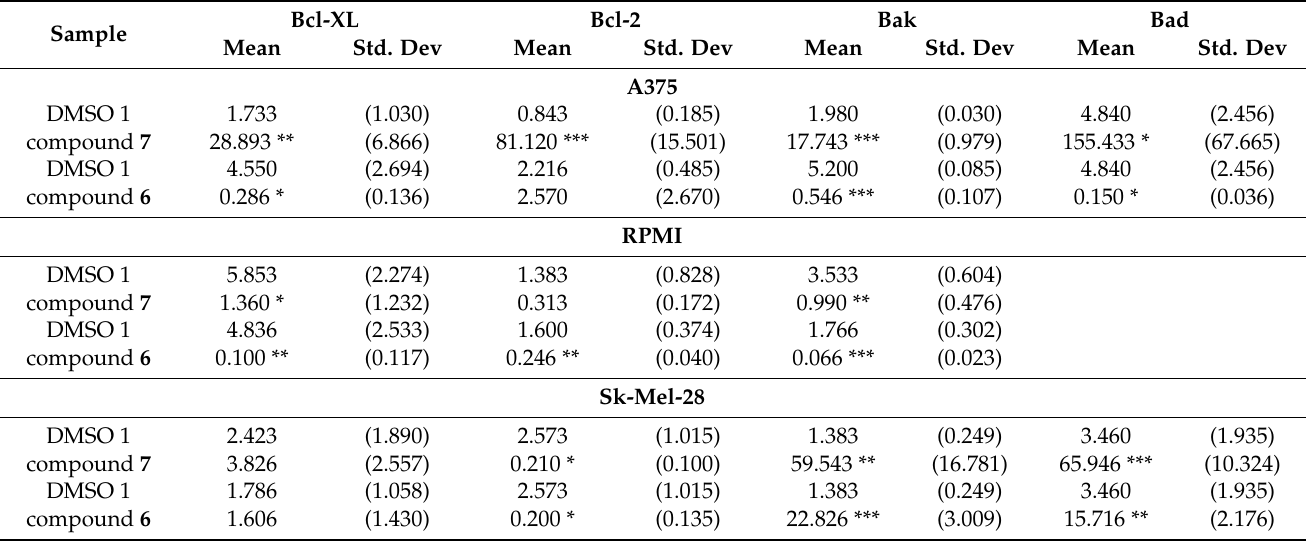
Table 4. Expression of the BAK, Bad, BCL-2, and BCL-XL genes for different treatments. Marked boxes (*) indicate significant differences as compared to the reference group (Test t test, ***- p < 0.001, **- p < 0.01, *- p < 0.05).